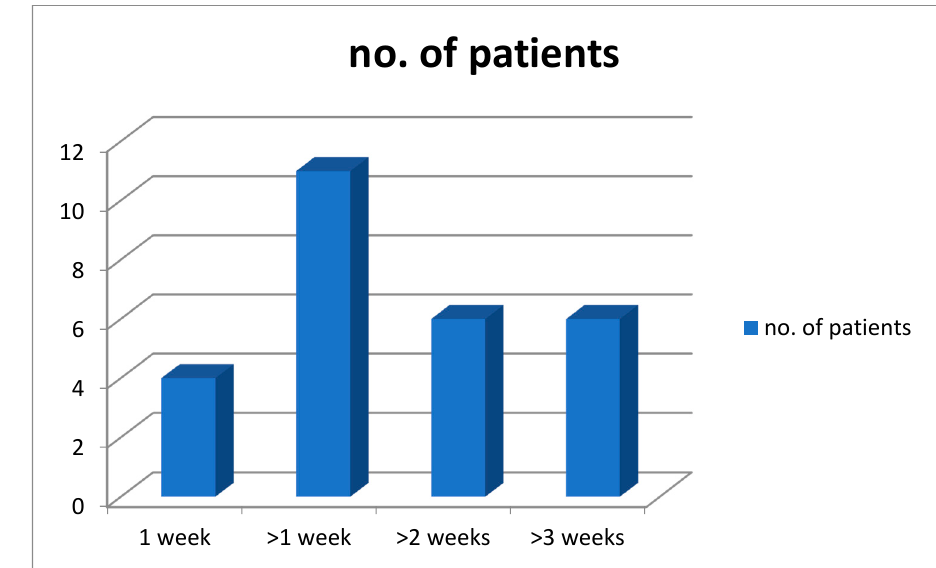
Figure 2. Duration over which patient stayed on ECMO.